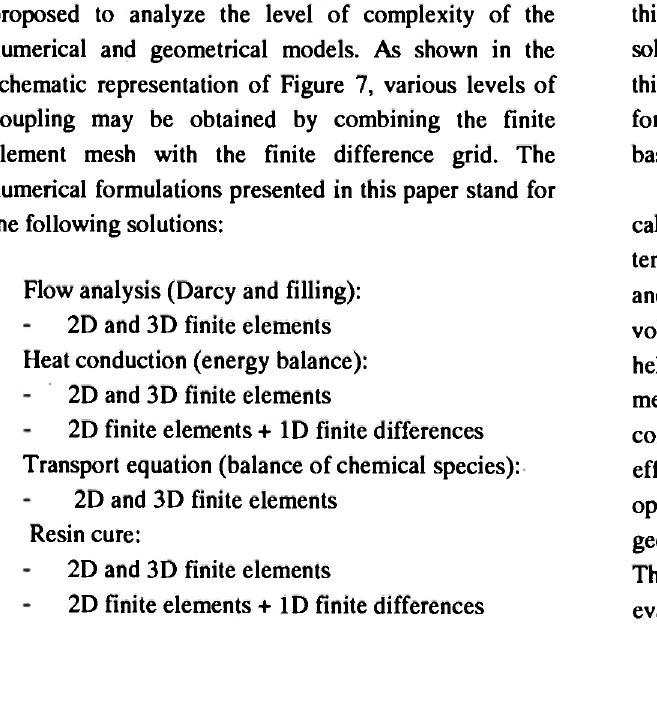
The possible combinations between these approximations are listed in Table 1. Different levels of integration of the flow, thermal and curing formulations are possible. In the simplest coupling, the flow is evaluated on the 2D mesh and the energy balance is studied with the 2D finite element space and ID